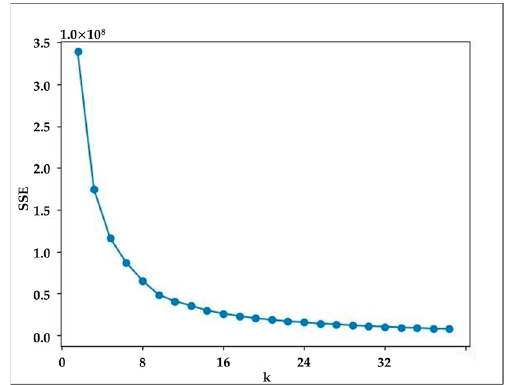
Figure 4. The sum of squares of error SSE under different K values.